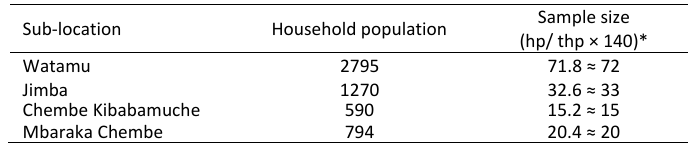
Table 3: Sample size of the population obtained from four sub‐locations in Watamu ward